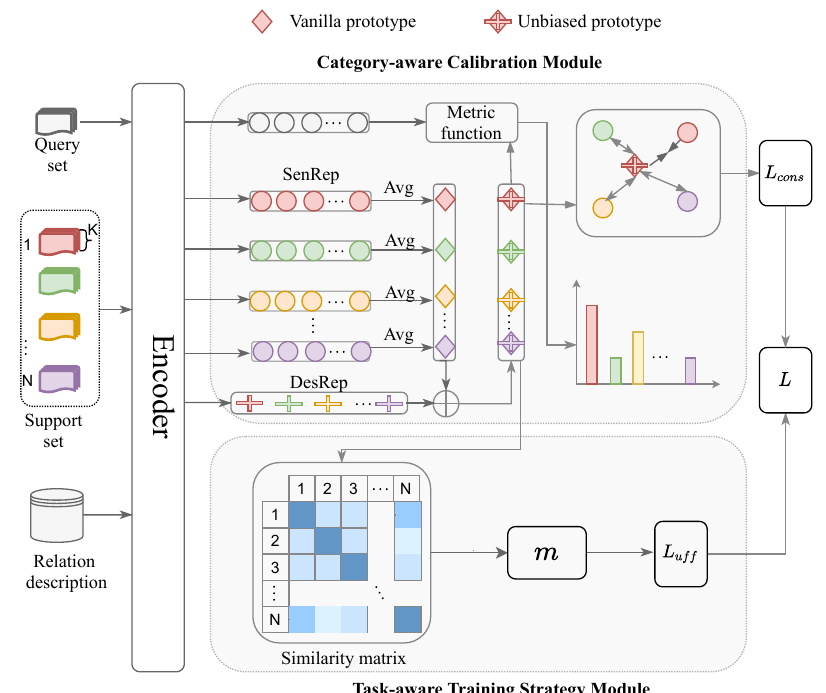
Figure 2. An overview of the few-shot relation extraction framework. Support set follows N-way K-shot setting. Different colors in the support set denote different relations categories. “SenRep” and “DesRep” denote the abbreviations of sentence semantic representation and relation description representation,